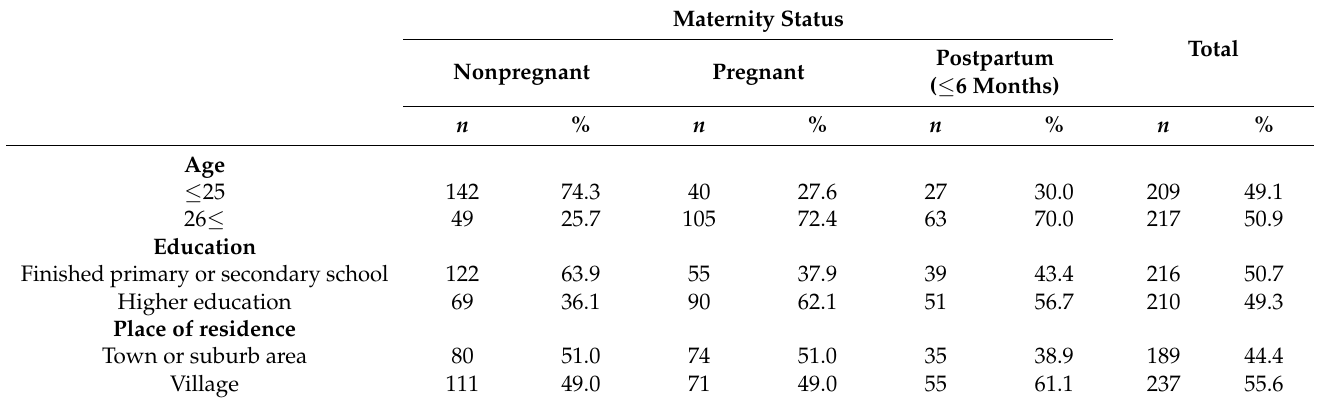
Table 1. Demographic data of surveyed population ( n = 426).